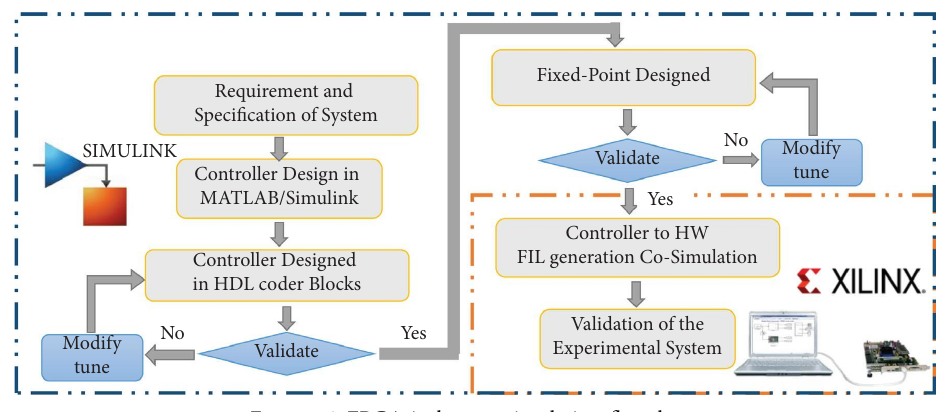
Figure 6: FPGA in loop cosimulation fowchart. Table 2: System